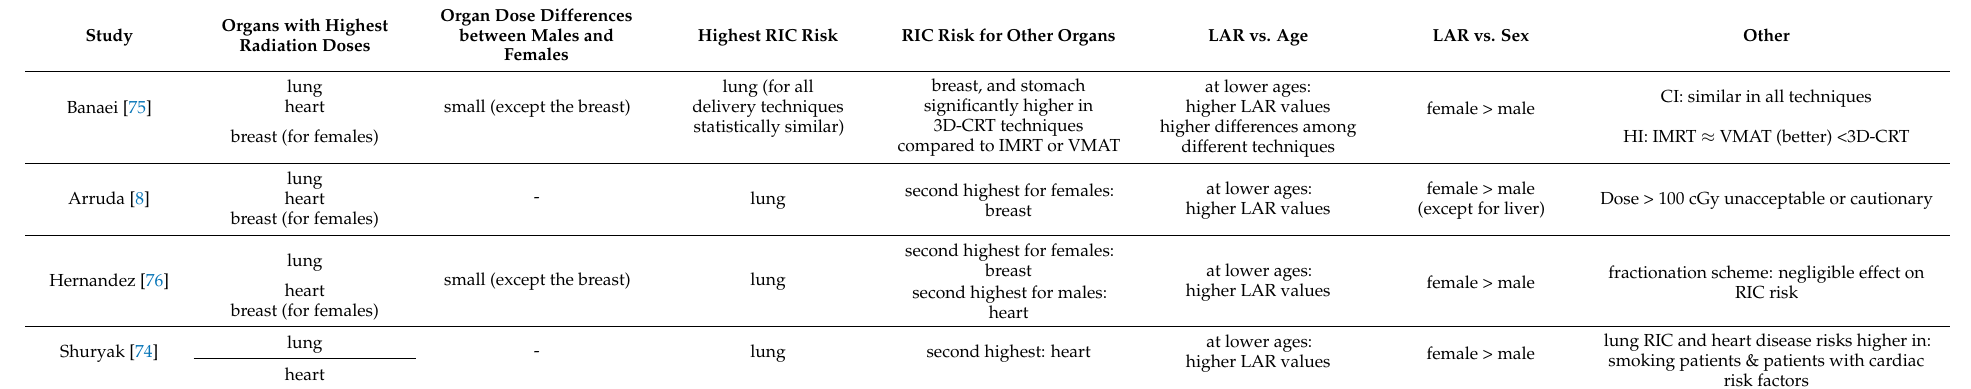
Table A5. Results for the radiation-induced risk assessment. The main endpoints from each study are